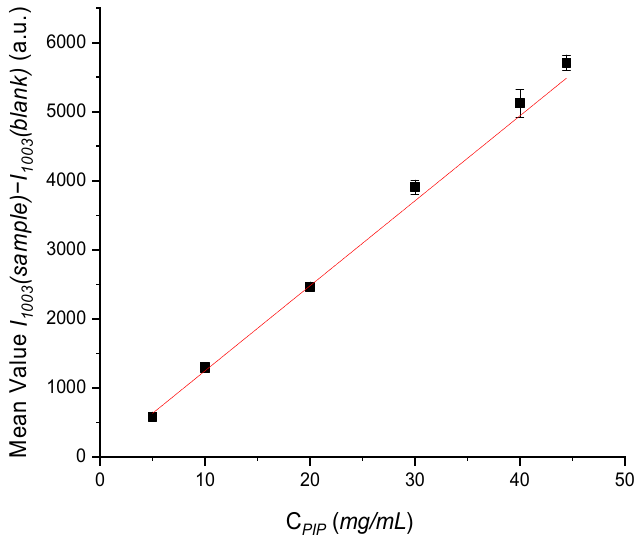
Figure 13. Calibration curve of PIP for standard solutions of liquid formulation placed in the drip chamber before administration, with concentration values ranging from 44.44 to 5.00 mg/mL.